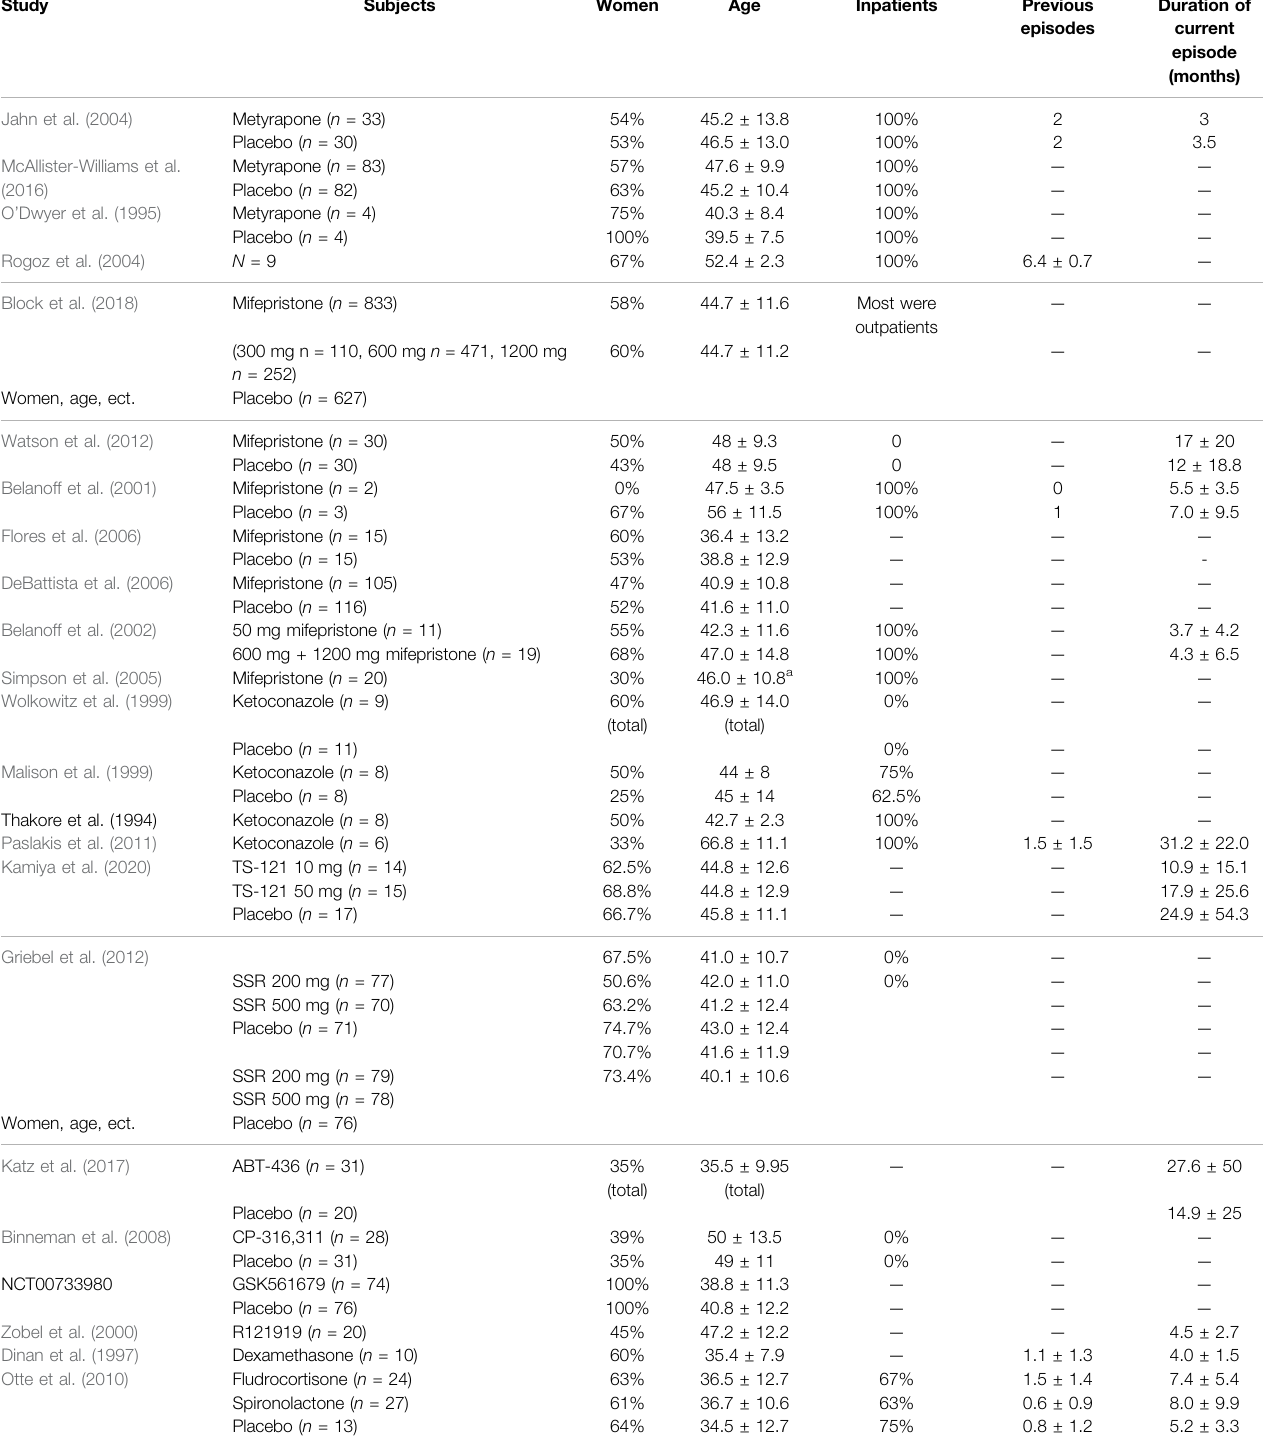
TABLE 2 | Demographic and clinical characteristics of the included subjects. Study Subjects Women Inpatients Previous